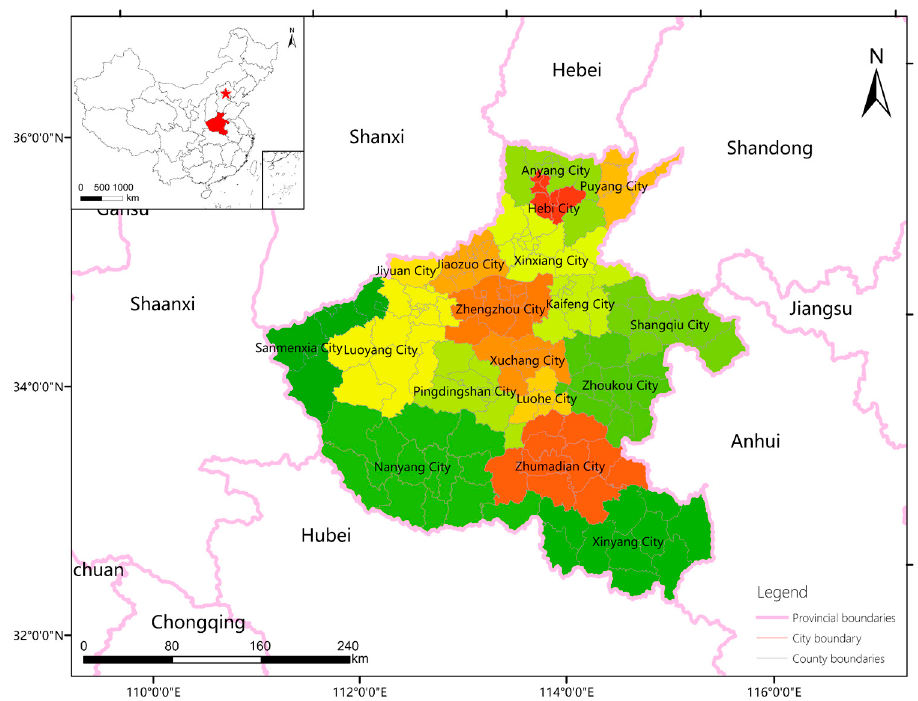
Figure 2. The location of Henan Province. The asterisks in the small picture represent Beijing, the capital of China. The different colours in the diagram represent each city in Henan Province. (The map is based on the standard map of the Technical Review Centre for Maps of the Ministry of Natural Resources (accessed on 26 August 2021) (review number: GS (2019) 1822), with no modifications to the base map.)